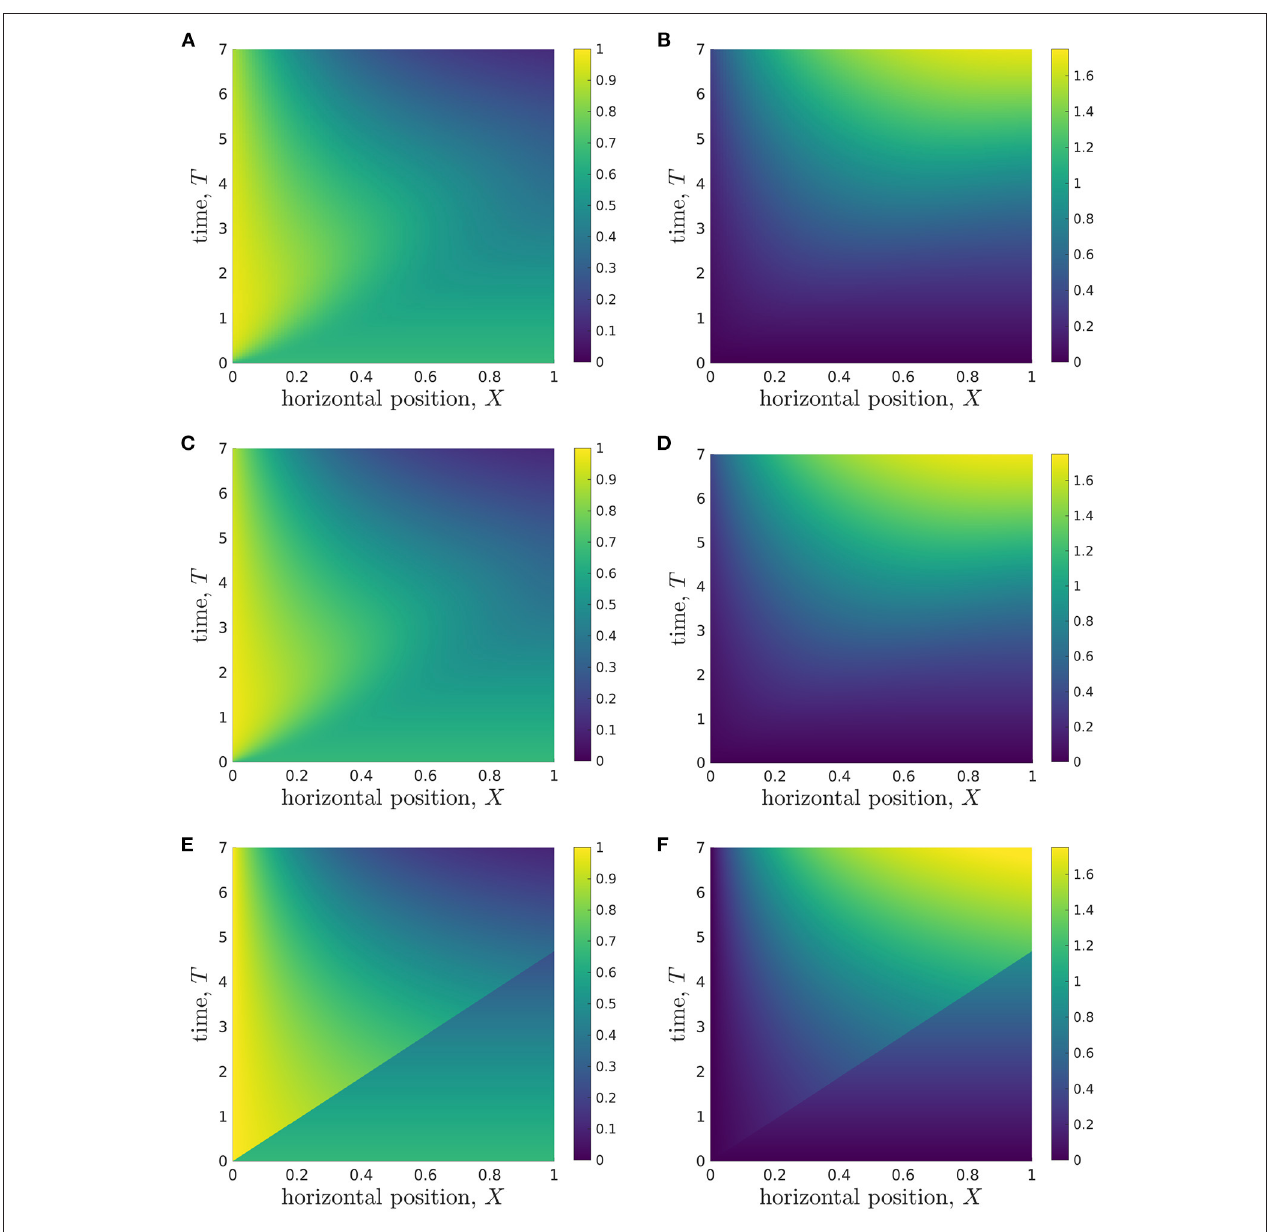
FIGURE 4 | Results showing how the glucose (A,C,E) and lactate (B,D,F) concentrations change over time during a typical simulation. (A,B) Results from Z -averaged full model. (C,D) Longwave approximation. (E,F) Sublimit of longwave approximation, where the upper left and lower right regions are the replenished and unreplenished regions, respectively. Parameter values: see Table 3